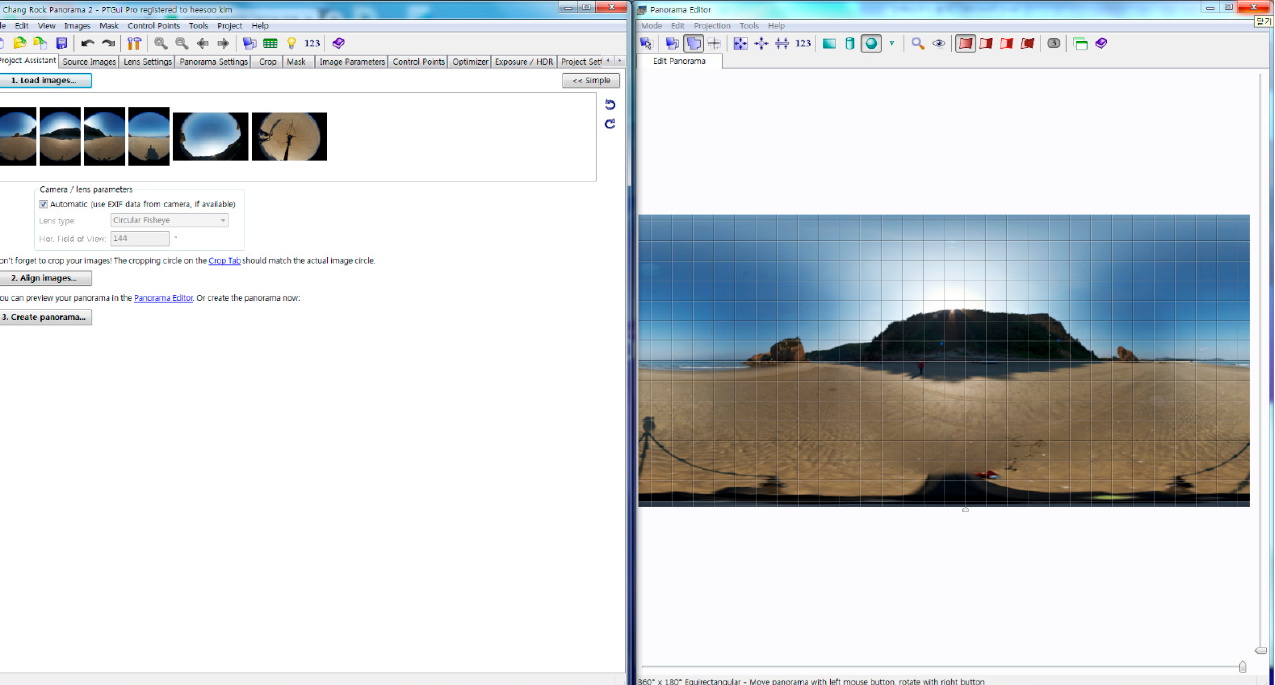
Figure 2. Stitching of aerial and ground photographs using PTGui.